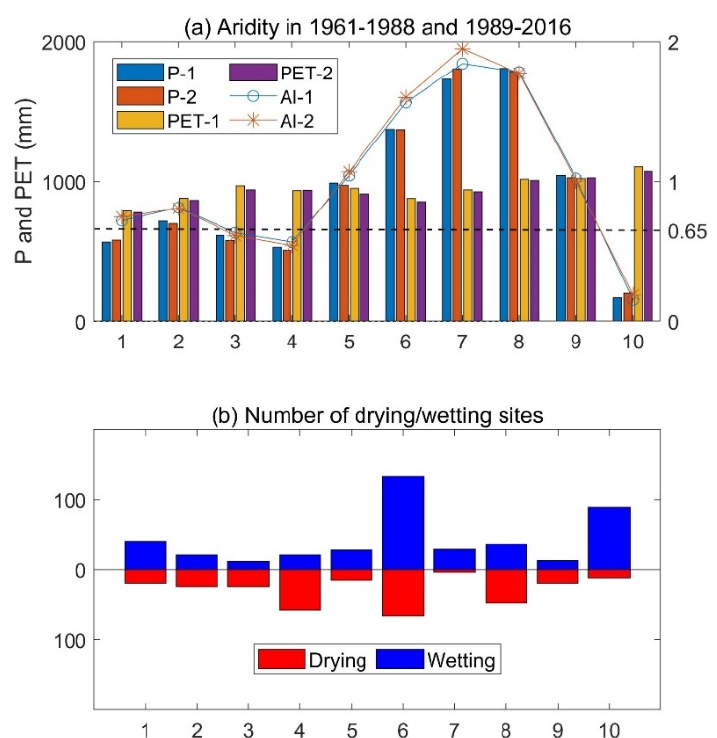
Figure 3. ( a ) Average precipitation (P), potential evapotranspiration (PET), and aridity index (AI) in 1961–1988 and 1989–2016 in the ten basins in China. ( b ) Number of sites getting drier or wetter from 1961–1988 to 1989–2016 within each basin. The first (1961–1988) and second time periods (1989–2016) are denoted by “-1” and “-2” in Figure 2a. On the x-axis, 1~10 represent the basins of Songhuajiang (1), Liao River (2), Hai River (3), Yellow River (4), Huai River (5), Yangtze River (6), Southeast (7), Pearl River (8), Southwest (9), and Northwest (10), respectively.